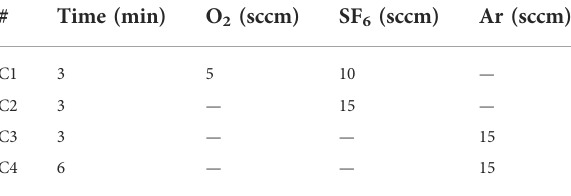
TABLE 1 Cleaning gas and their fl ow rates in the cleaning process C1 –